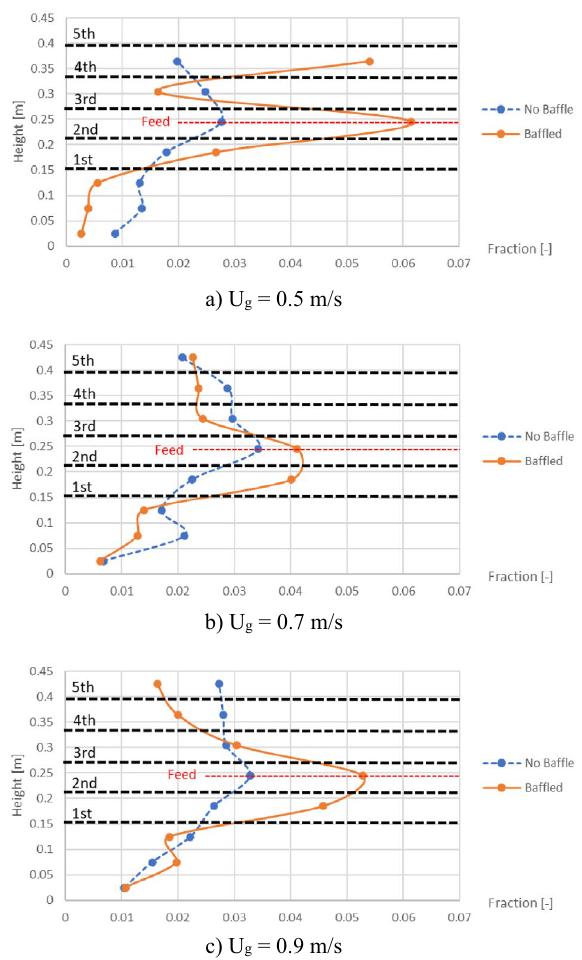
Figure 11. Time-and-area-averaged biomass fraction in bed before and after installing the baffles in case that biomass was fed at middle, when operating at various gas inlet